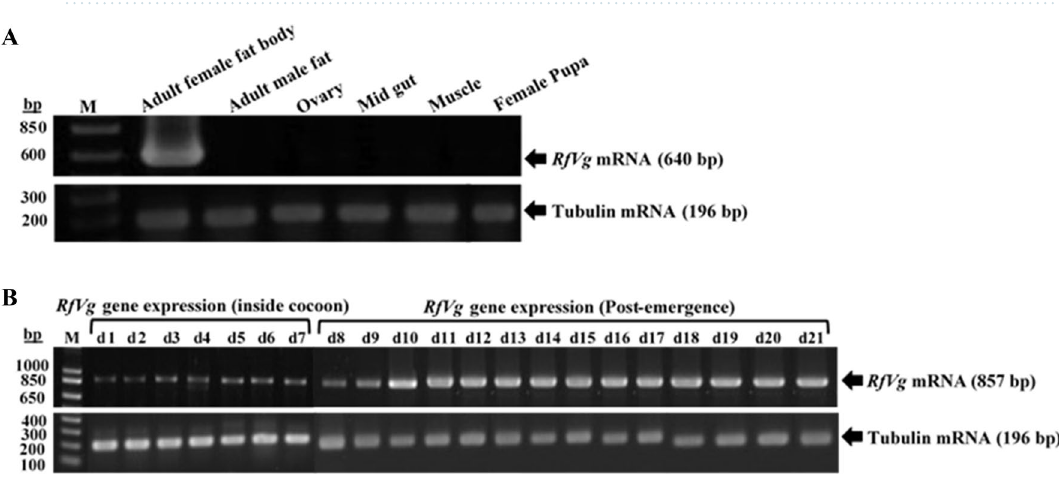
Figure 2. Expression pattern and temporal traits of RfVg gene transcription. (A) Expression pattern of RfVg and tubulin genes from different tissues of Rhynchophorus ferrugineus was analyzed by RT-PCR. Agarose gels (2%) were used to analyze the amplified PCR products. The M is a molecular marker (bp), while 640 bp and 196 bp on right side are amplified products of Vg and tubulin genes, respectively. (B) The RfVg and tubulin genes expression profile up to three weeks in the adult R. ferrugineus females analyzed by RT-PCR. The amplified bands were visualized under the UV light and photographed by using gel documentation BioDocAnalyze system (Biometra). d